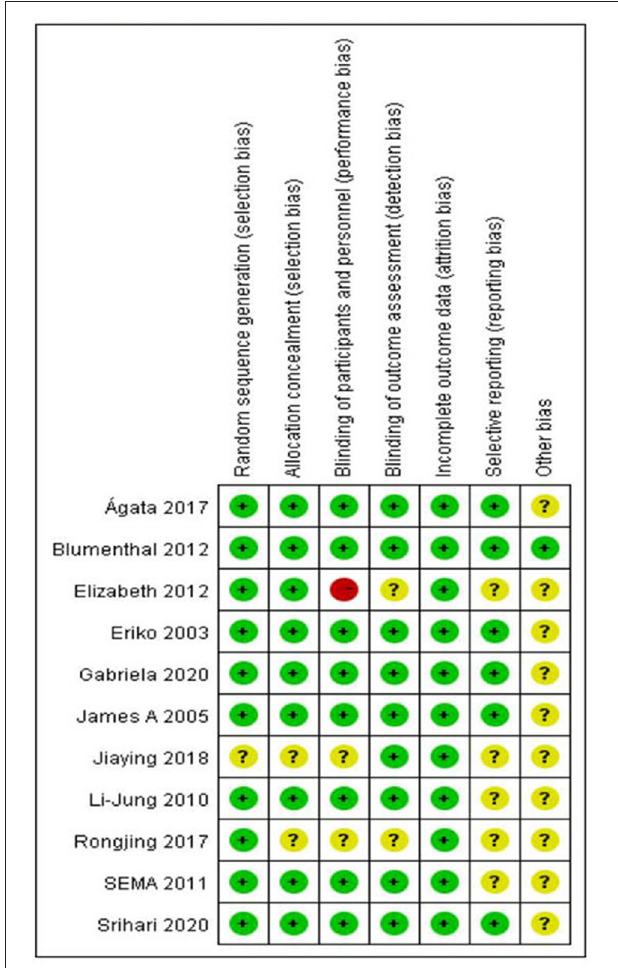
FIGURE 3 | Risk of bias summary review authors’ judgements about each risk of bias item for each included study.